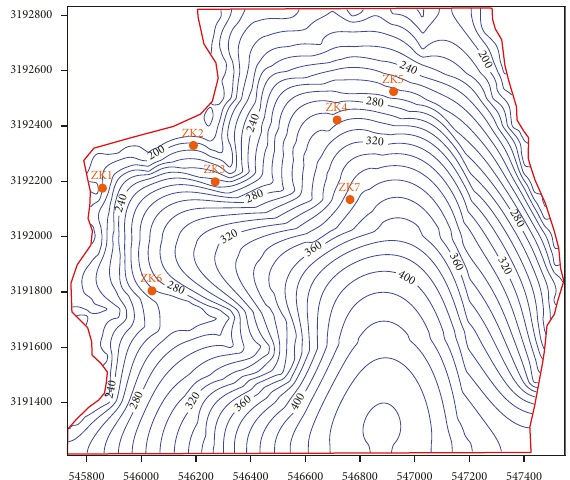
Figure 7: Initial flow field in the simulation area.